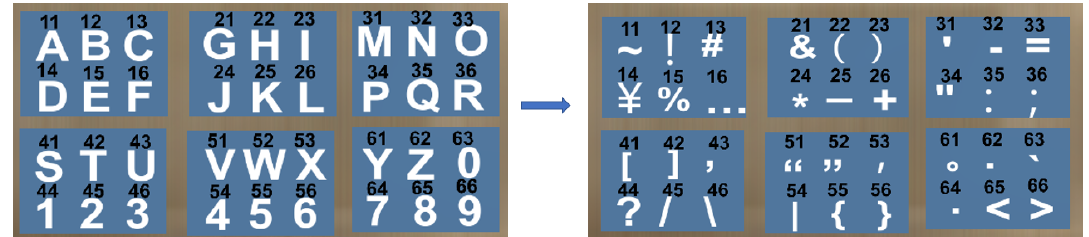
Figure 4. The switch between the alphabet and numbers and specific symbols.